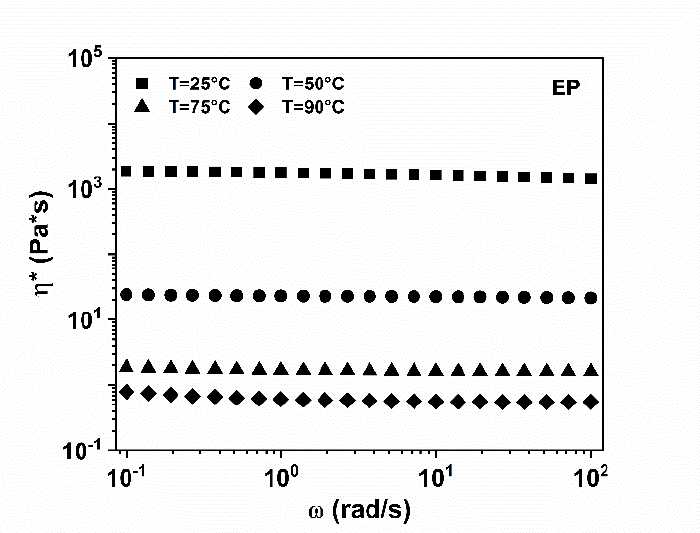
Figure 3. Complex viscosity ( η *) vs. frequency (ω) for the EP blend at different